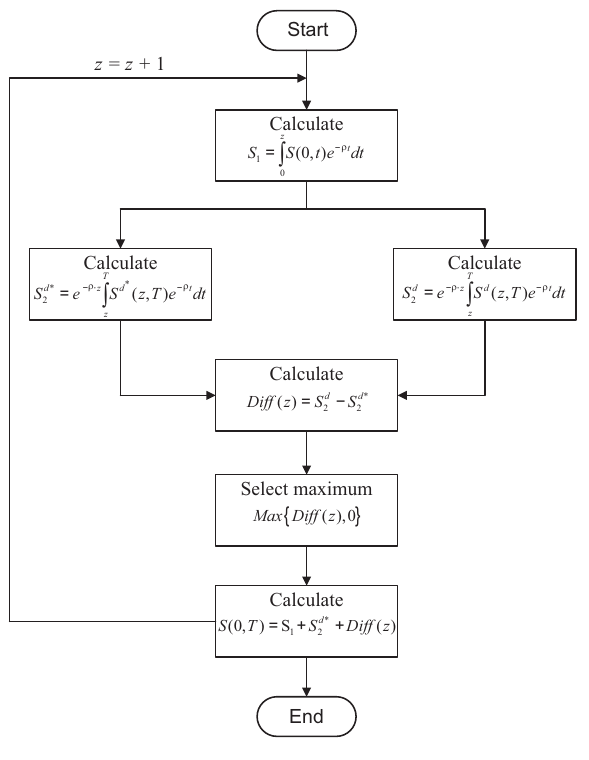
Fig. 1. Flowchart of the RO